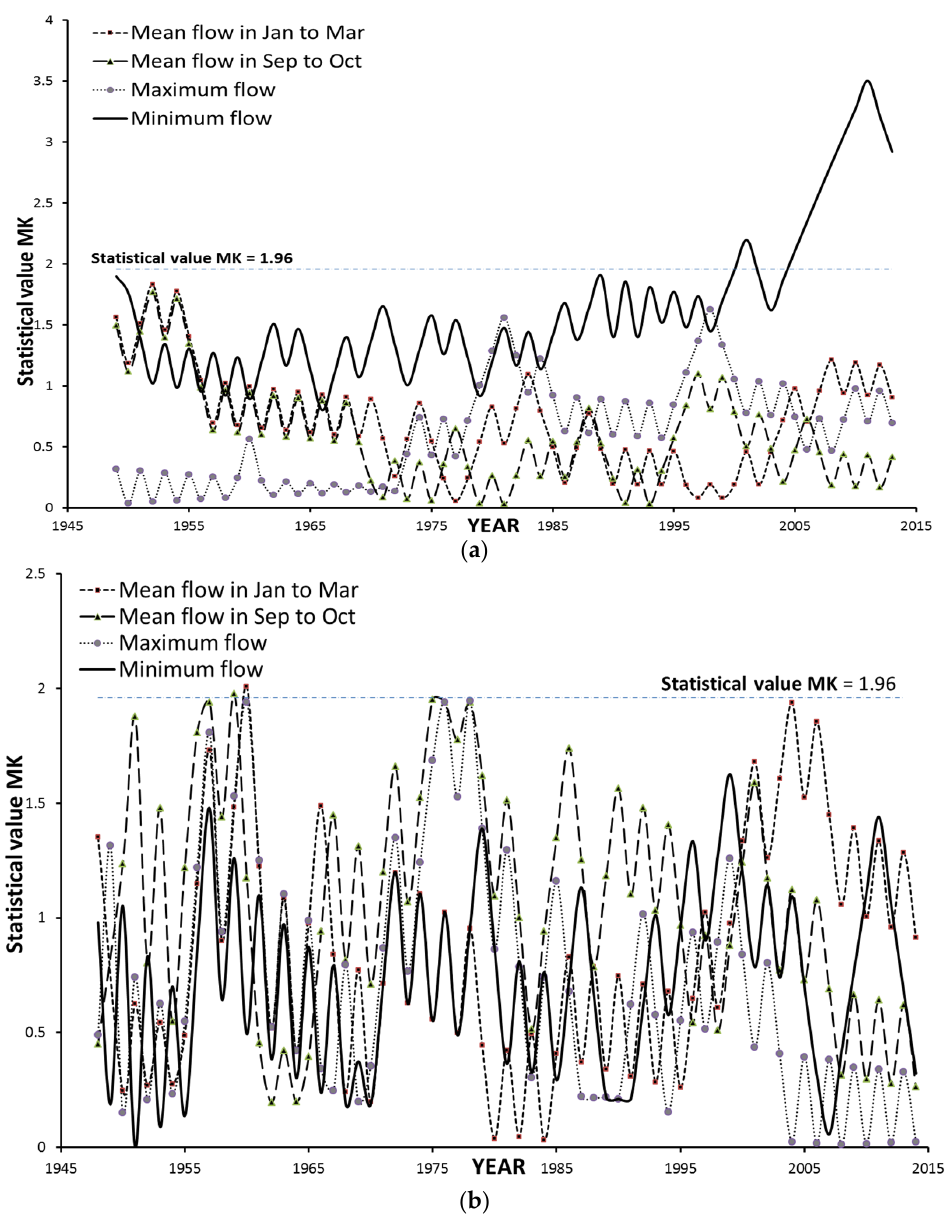
Figure 3. Critical values of runoff series by MK test. ( a ) Yichang Station; ( b ) Datong Station.